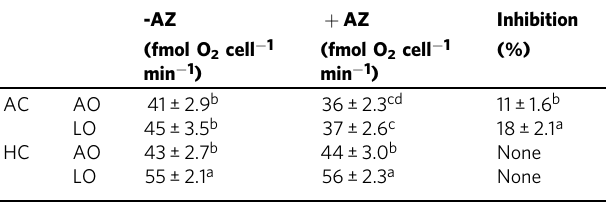
Values represent means±standard deviation ( n = 3) for replicate cultures under ambient (AO, ~255 μ M) and low O 2 levels (LO, ~57 μ M) with ambient (AC, ~15 μ M) and elevated CO 2 levels (HC, ~35 μ M), and different letters (superscripted) represent signi fi cant differences ( P <0.05, LSD test) among + AZ and − AZ treatments. Photosynthetic inhibition in high CO 2 -grown cells was not detected (none), while low O 2 -grown cells showed the highest photosynthetic inhibition.Thedetailed information forthe experimentalfeatures and timingpointsare shown in Supplementary Fig.